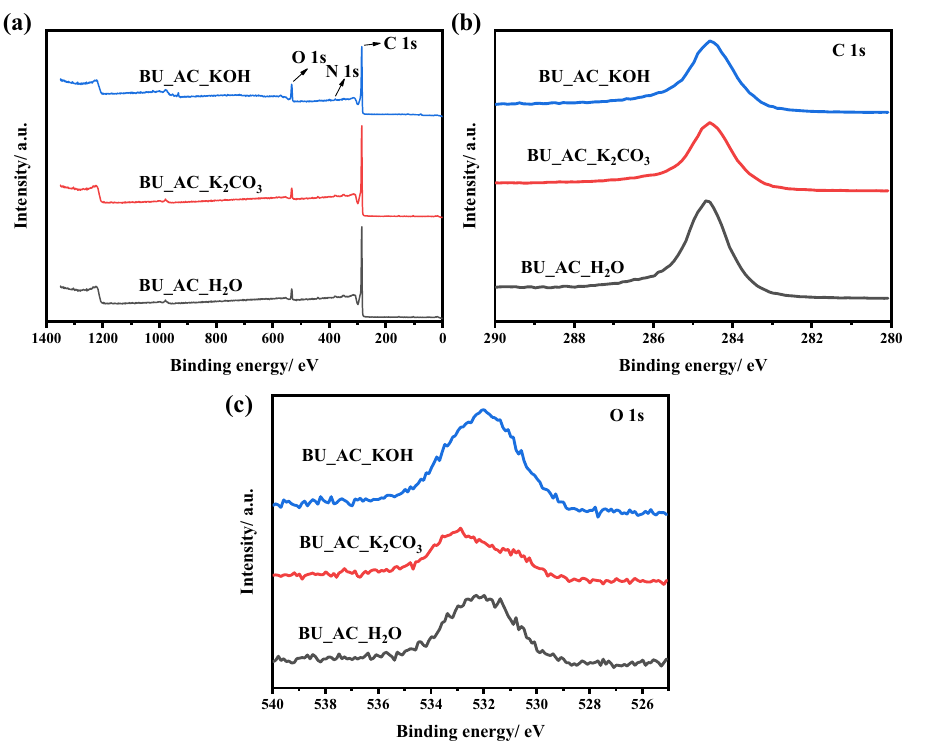
Figure 5. XPS survey spectra ( a ), high-resolution XPS spectra of C 1 s ( b ), and O 1 s ( c ) of BU_AC_H 2 O, BU_AC_K 2 CO 3 , and BU_AC_KOH porous materials.